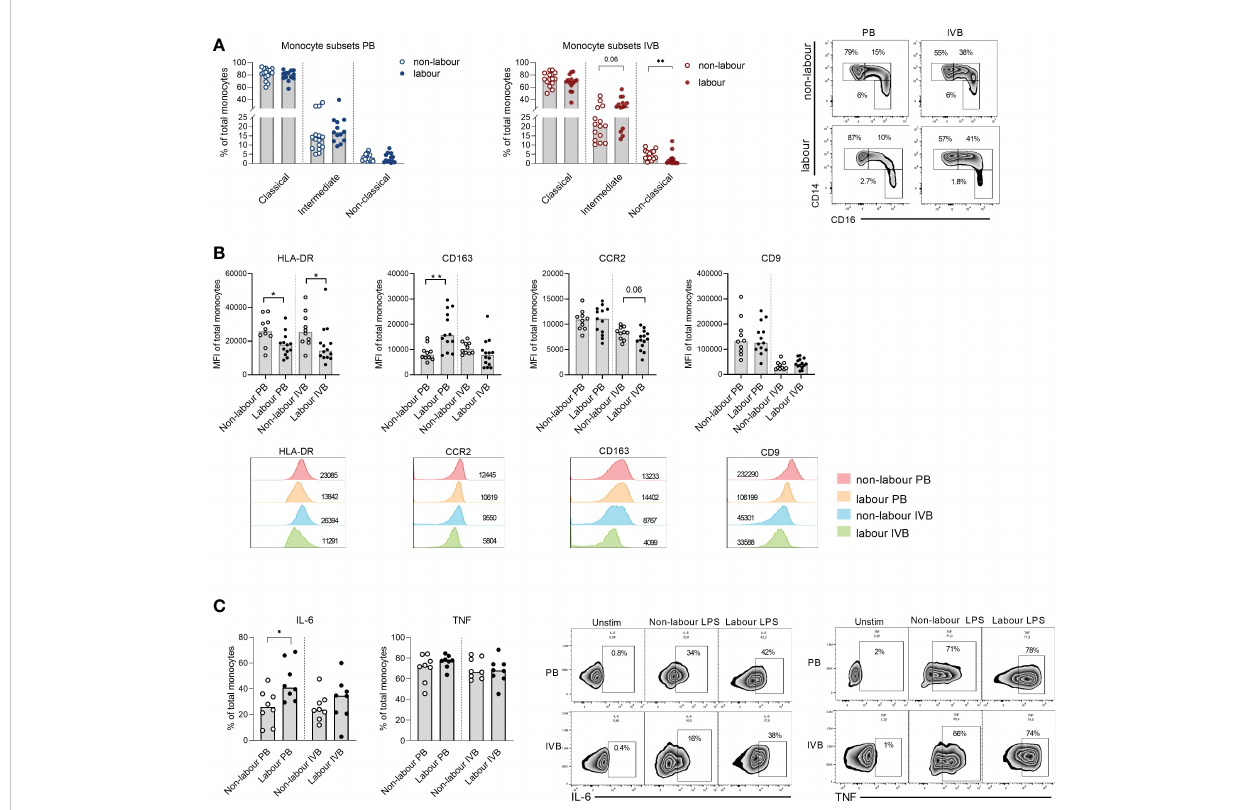
FIGURE 2 Labour leads to an altered phenotype and function of monocytes. (A) Proportions of monocyte subsets (classical (CD14 + CD16 - ), intermediate (CD14 + CD16 + ), and non-classical (CD14 low CD16 + )) in peripheral (PB) and intervillous blood (IVB) from women delivering with labour (n=13) or without labour (n=15) (left and middle), and representative dot plots (right). (B) Median fl uorescence intensity (MFI) of HLA-DR, CD163, CCR2 and CD9 in PB and intervillous blood from women delivering with labour or without labour. Representative histograms showing MFI for HLA-DR, CD163, CCR2 and CD9. (C) Mononuclear cells from PB and IVB isolated from women delivering with labour (n=8) and without labour (n=8) were activated with LPS for 4h, fi xed and stained with anti-IL-6 and anti-TNF antibodies and analysed with fl ow cytometry (left). Representative fl ow cytometry histograms are shown to the right. Statistical differences were determined with Mann-Whitney test (A – C) , *p<0.05,